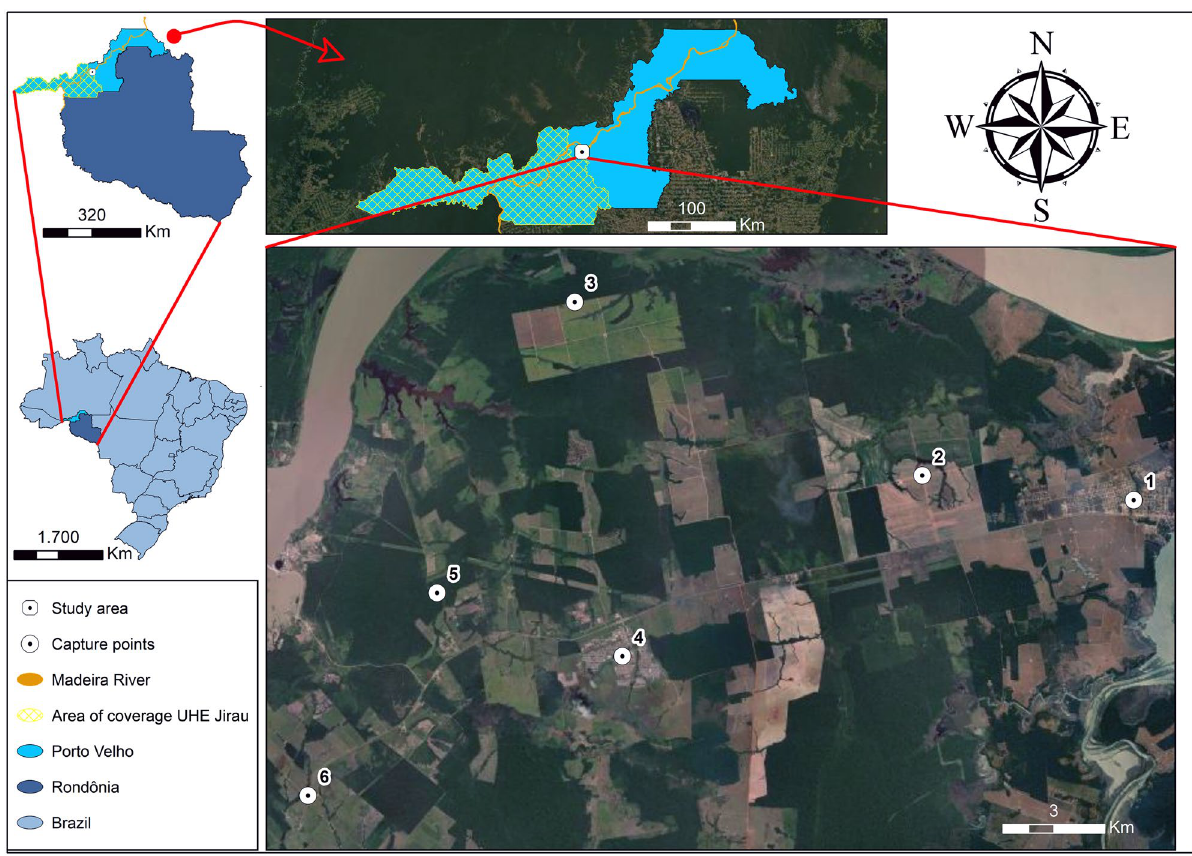
Figure 1. Sampling points, Jaci Paraná (1); Agrícola Zamo (2); Agrícola Zamo 2 (3); Nova Mutum Paraná (4); Right polygonal (5); Farm BR 364 KM 828 (6) located in the state of Rondônia, Brazil. Source Google Earth, satellite image/Pass date: June